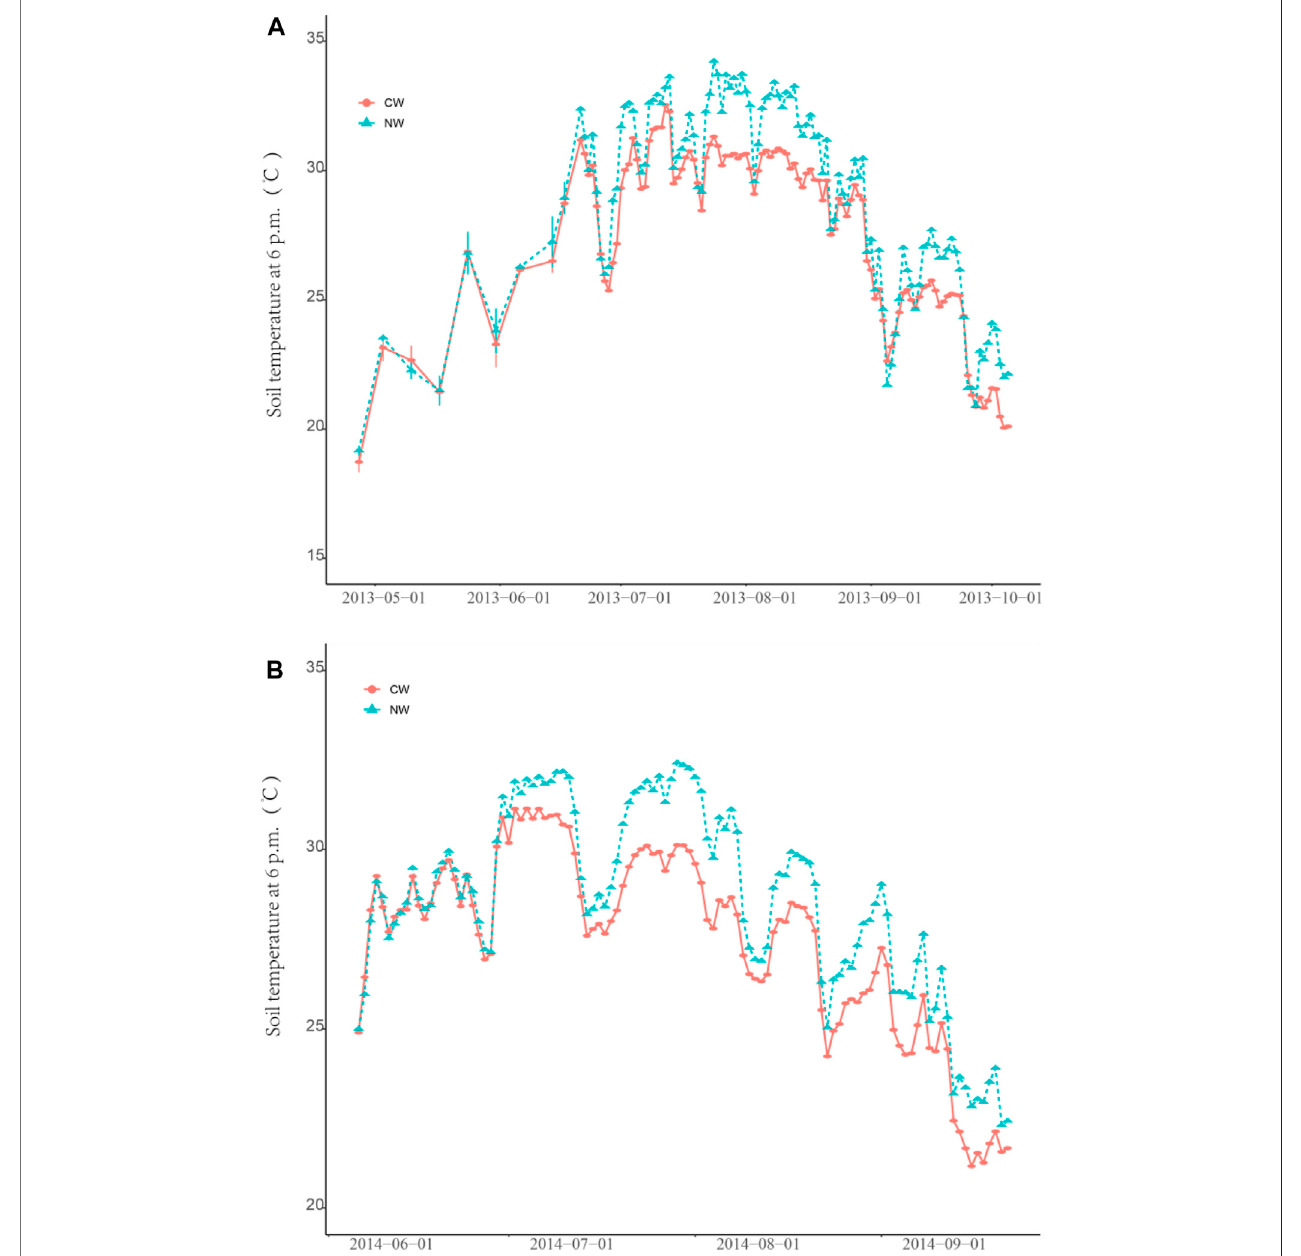
FIGURE6| Annualvariationtrendofsoiltemperatureandtemperaturedifferenceduringhightemperatureperiod.Note:Buriedthreetemperaturerecordersineach fi eld. (A) and (B) are the annual variation trend of 5 cm soil temperature during the monitoring period in YX site and DY site, respectively.